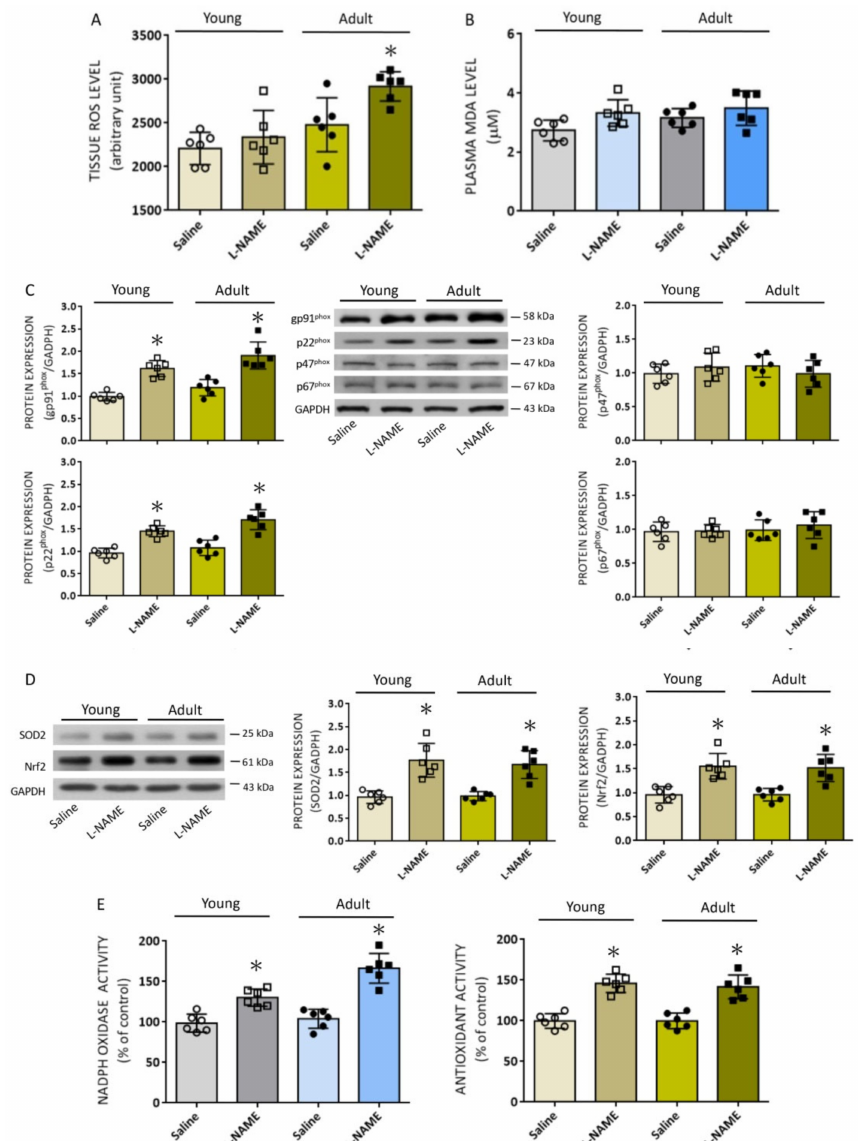
Figure 4. Effect of systemic L -NAME treatment on reactive oxygen species (ROS) levels and expression of proteins involved in ROS production and degradation. Data showing ROS levels in RVLM ( A ) and MDA levels in plasma ( B ) of young (8 weeks, open circles or squares) or adult (20 weeks, filled circles or squares) rats after i.p. infusion of saline or L -NAME (10 mg/kg/day) for 14 days. Also shown are representative gels (insets) and densitometric analysis of results from Western blot changes in protein expression of pg91 phox , p22 phox , p47 phox , and p67 phox ( C ) or SOD2 and Nrf2 ( D ), as well as enzyme activity of NADPH oxidase and total antioxidants ( E ) in RVLM 14 days after saline or L -NAME treatment. Data on protein expression are normalized to the respective saline control value, which is set to 1.0. Data are presented as mean ± SD, n = 6 per group. * p < 0.05 versus